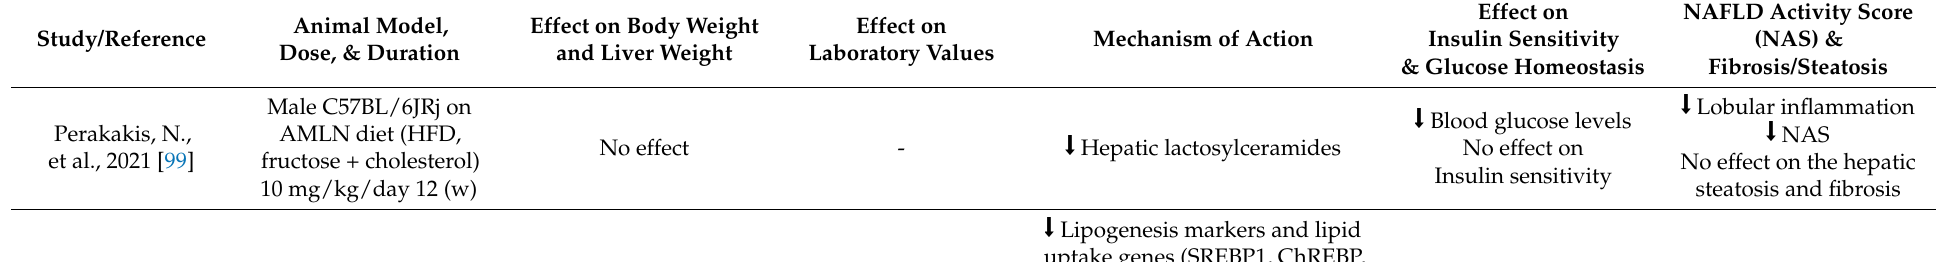
Table 1. Key animal studies regarding the impact of empagliflozin on NAFLD/NASH.